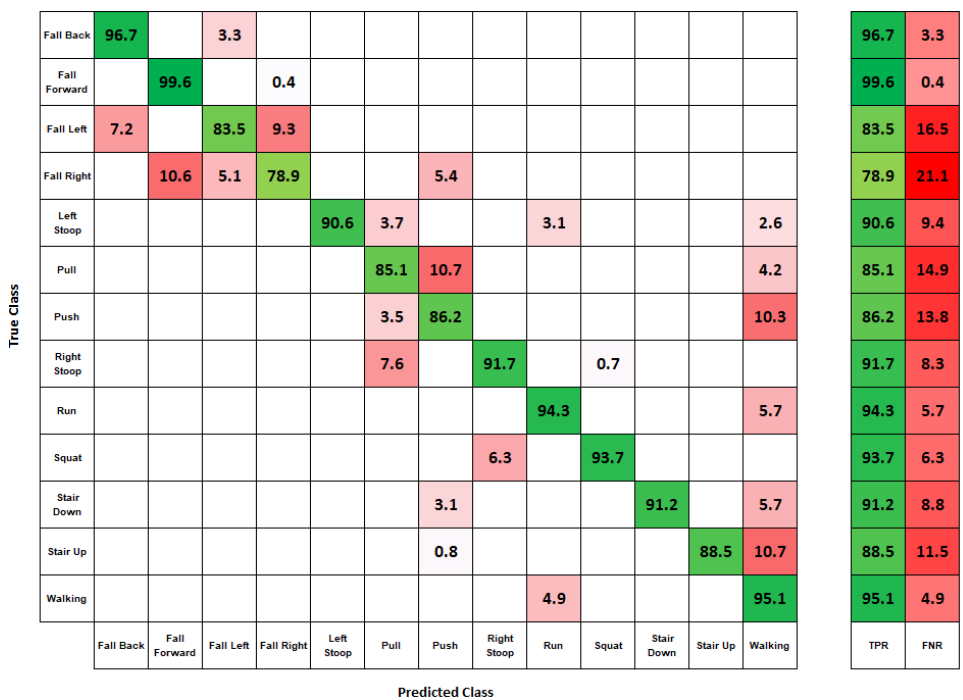
Figure 17. Movement detection results from 34 subject data. True Positive Rate (TPR) and False Negative rate (FNR). Negative rate